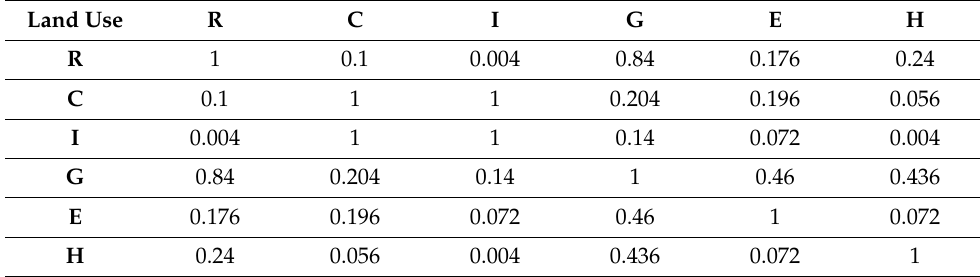
Figure 5. Index value of four indicators derived from the hypothetical dataset. ( a ) Spatial compactness; ( b ) land use compatibility; ( c ) land use entropy; and ( d ) evenness. Table 4. Land use compatibility